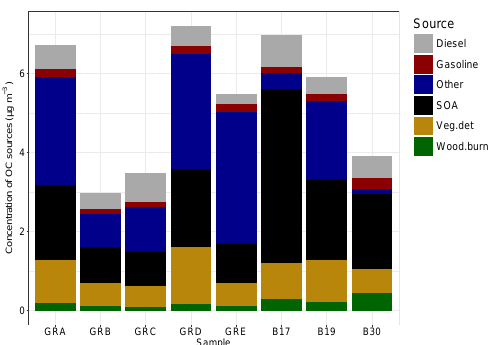
Figure 10. Source contributions attributed to the OC fraction of the PM 10 filter samples by filter groups, where GRA is group A, GRB is group B, etc. and B17, B19, and B30 are individual filters. More information on the filter groups, including some basic composition information and back trajectory origin, can be found in Table 3.